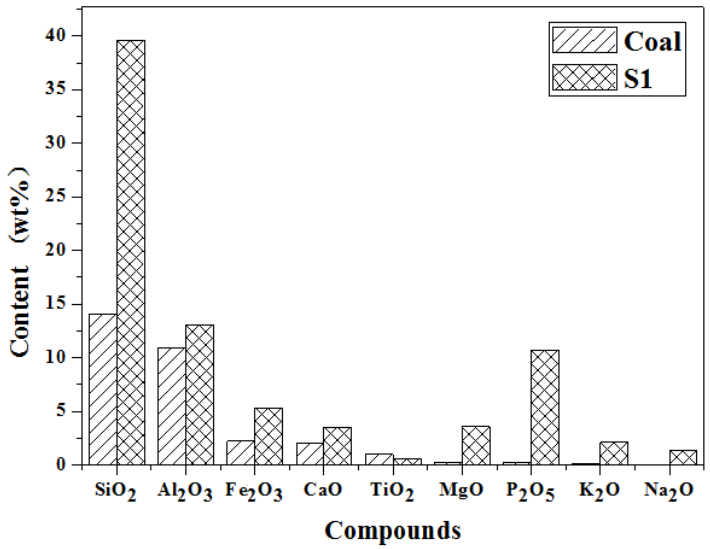
Figure 3. Inorganic compositions of coal and S 1 .